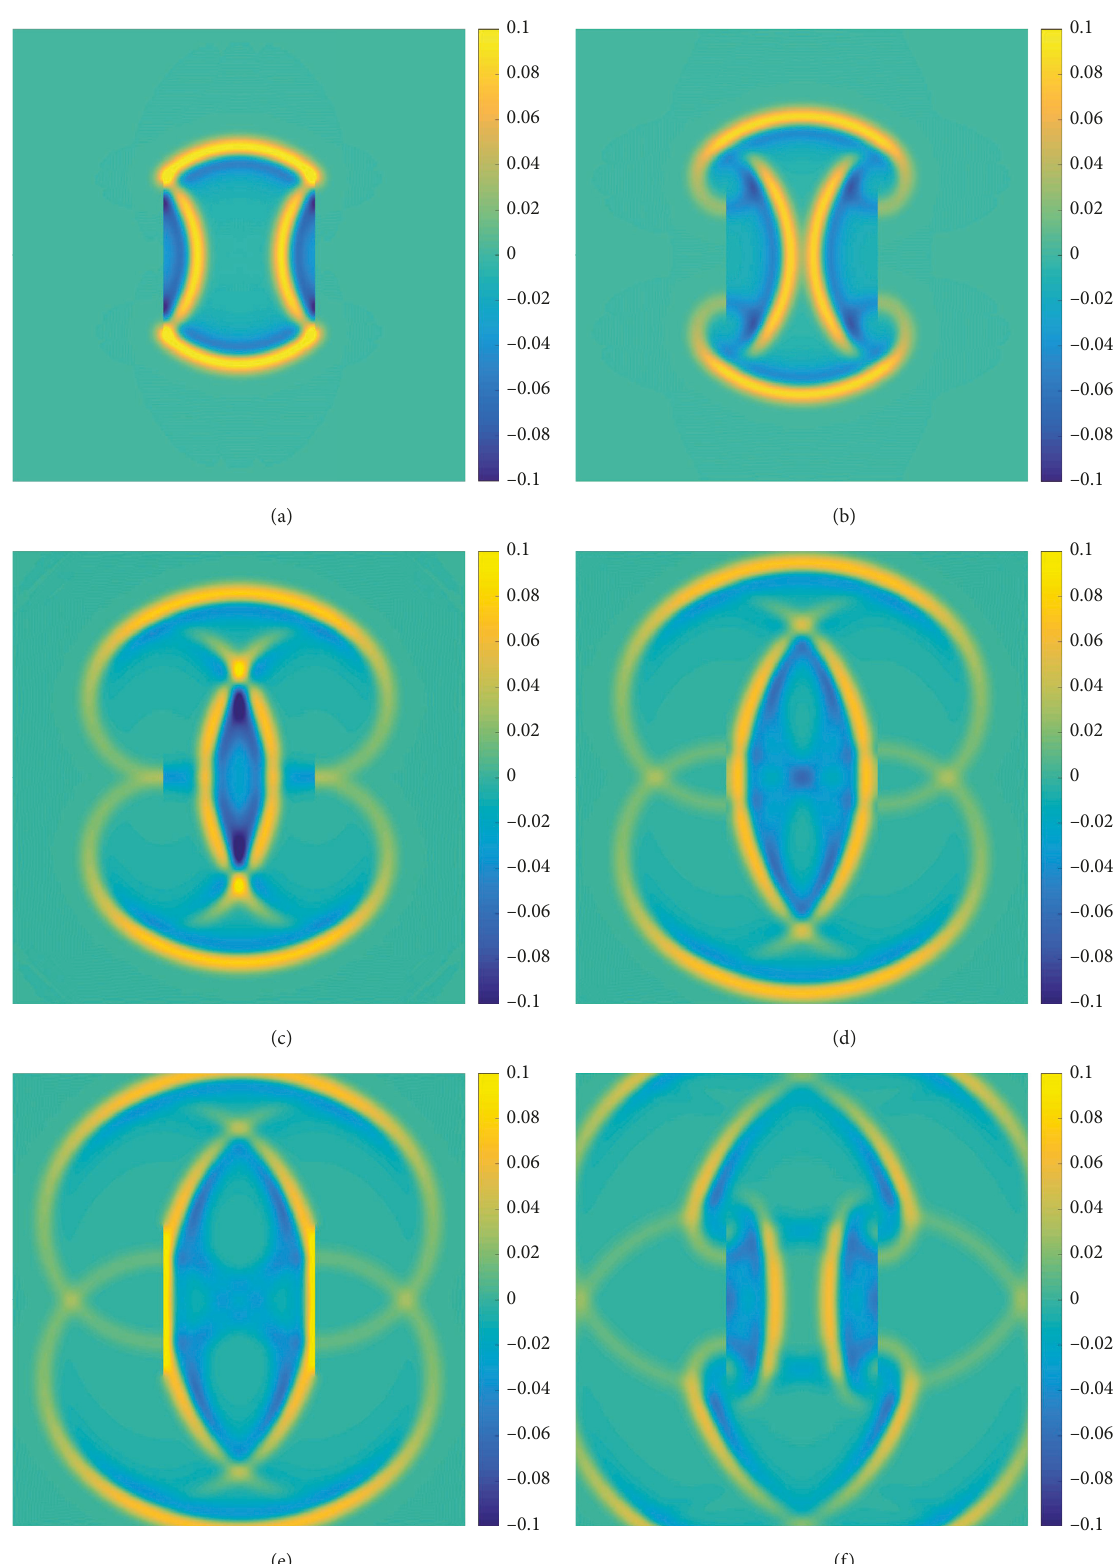
Figure 9: Velocity distribution in the z direction (a) at time � 0.7s, (b) at time � 0.9 s, (c) at time � 1.2s, (d) at time � 1.4 s, (e) at time � 1.5s, and (f) at time �